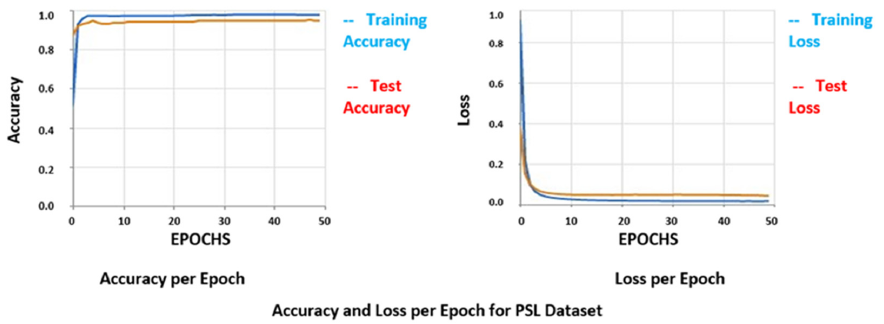
Figure 11. Hand gesture detection results for PSL dataset.